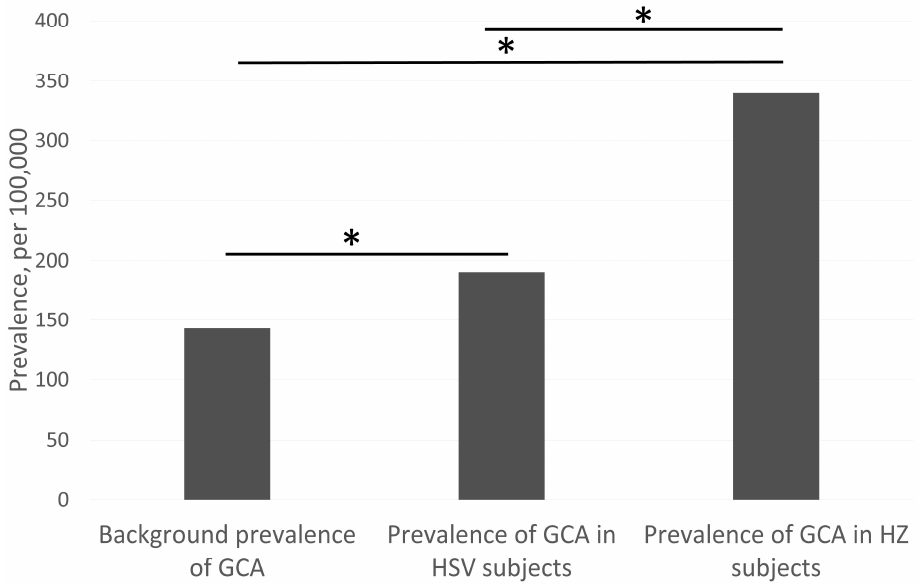
Figure 1. Comparison of the prevalence of giant cell arteritis (GCA) in British Columbia (BC) of the general population, patients with previous herpes simplex virus (HSV) and previous herpes zoster (HZ). Includes BC residents ≥ 30 years of age at the time of diagnosis. * represent significant differences at p < 0.00001.